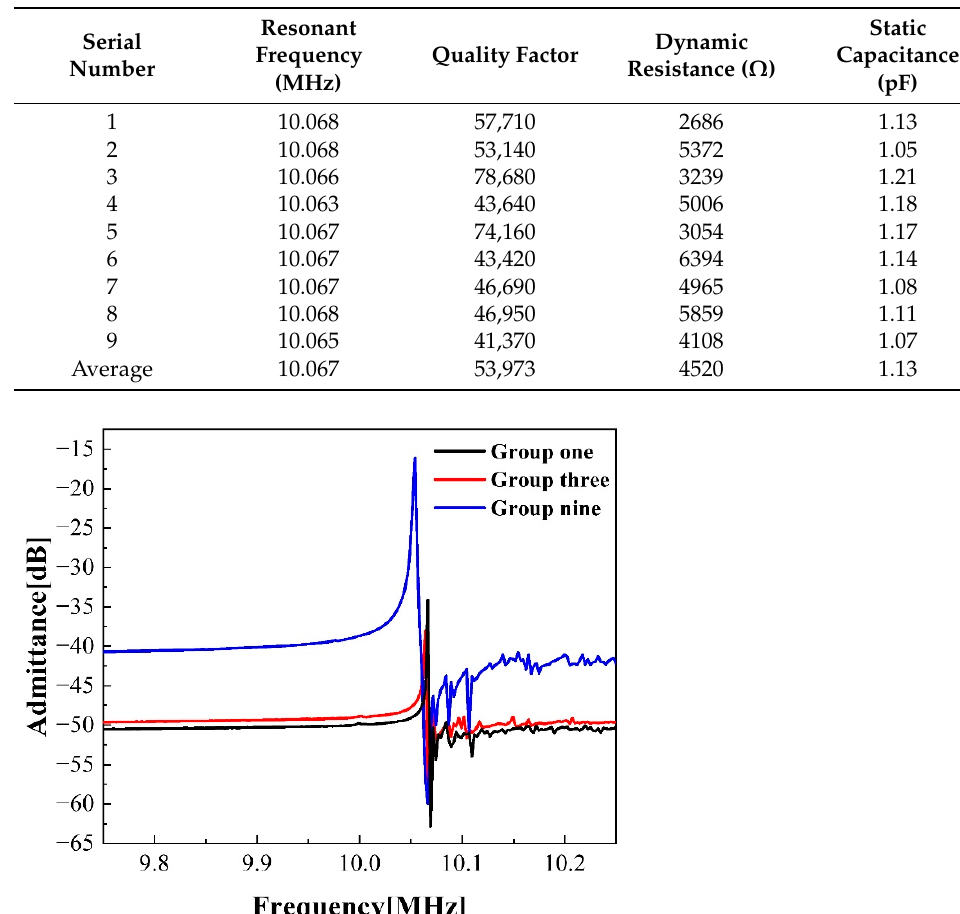
Table 2. Measurement characteristics of QCM with double-finger electrode.